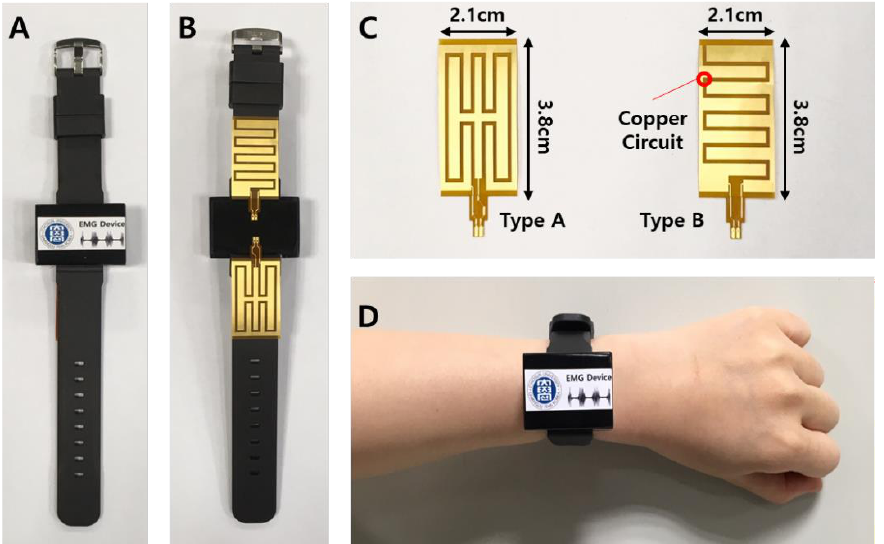
Figure 3. ( A , B ) Wearable EMG detection module. ( C ) Two types of flexible dry electrodes. ( D ) EMG system worn on wrist.